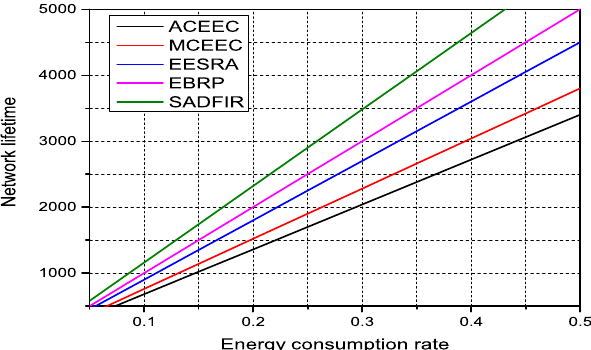
Figure 11. Energy consumption rate as network operation progress in network of 100 m × 100 m with 100